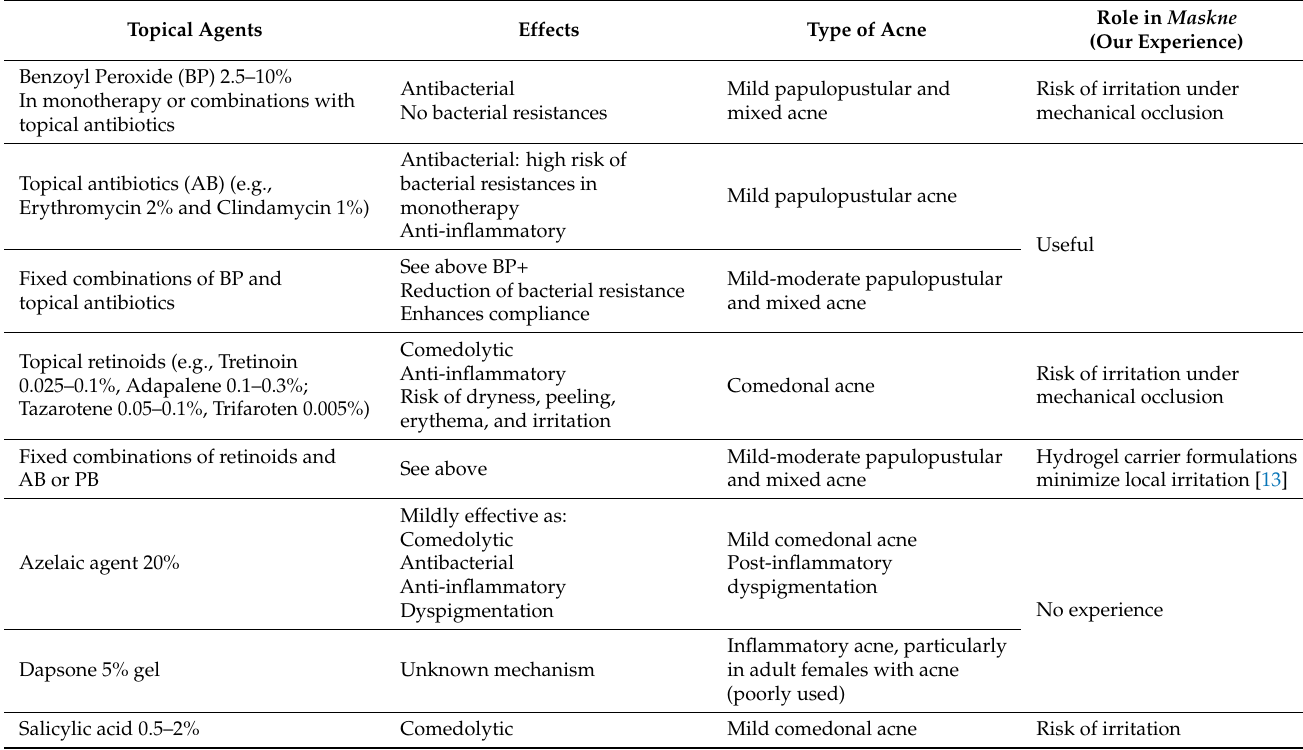
Table 1. Topical therapies in